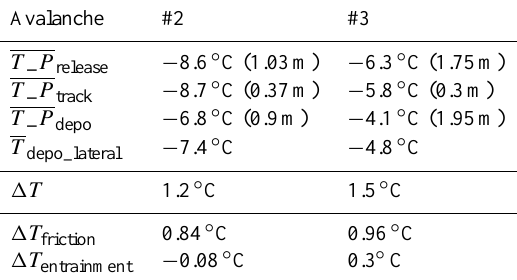
Table 2. Depth averaged temperatures of release ( T _ P release ), track ( T _ P track ) and deposition profile ( T _ P depo ) with the correspond- ing release and erosion depths (in brackets). T depo_lateral represents the mean of the lateral temperature measurements in the deposi- tion. (cid:49)T is the difference between T depo_lateral and T _ P release . (cid:49)T friction and (cid:49)T entrainment are the individual contributions to (cid:49)T